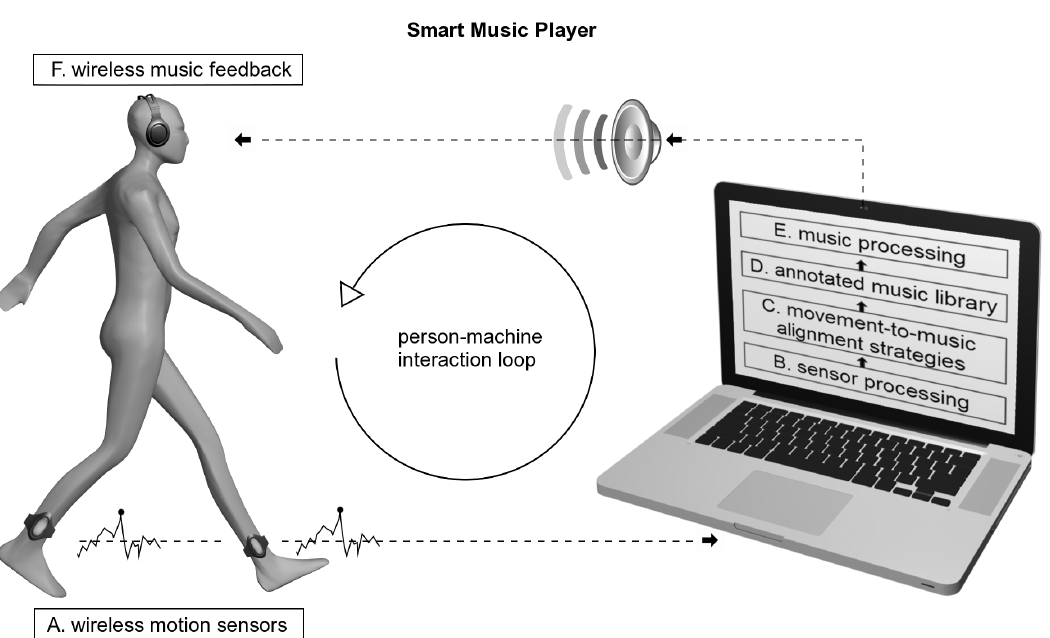
Fig. 1. Smart music player: person-machine interaction loop and the main components